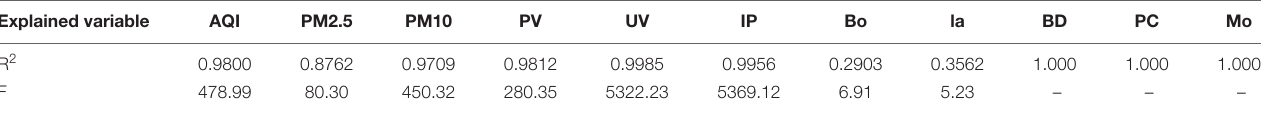
TABLE 1 | Fitting goodness and F test statistic of auxiliary regression. Explained variable AQI